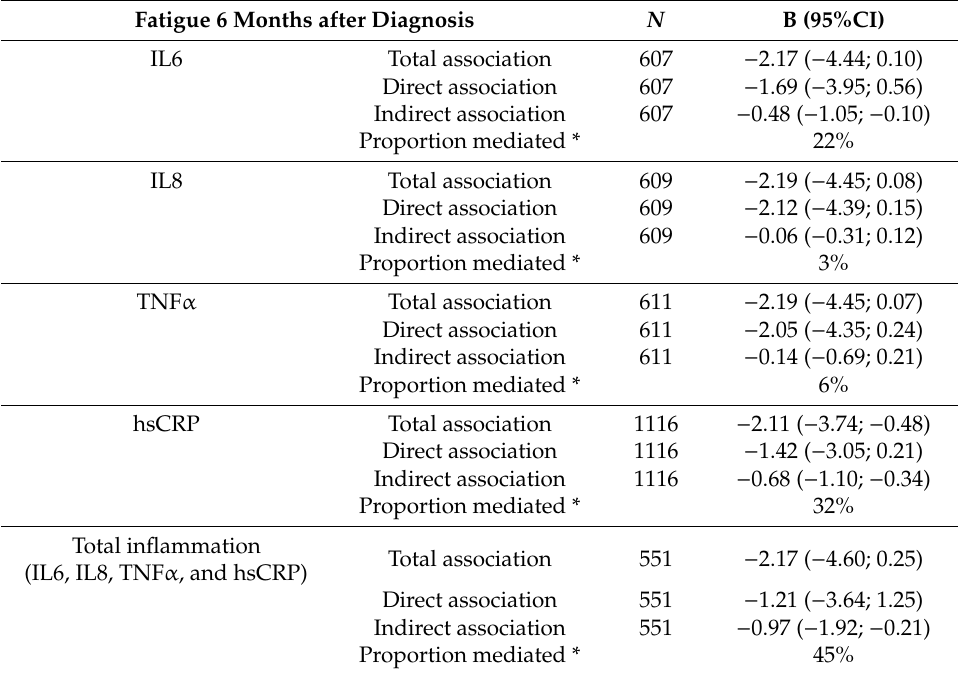
Table 4. The association between lifestyle and fatigue (total association), divided in an direct